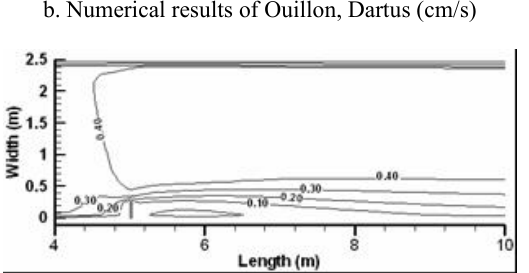
Fig.3 Isolines of velocity around the groyne at z=+0.17m